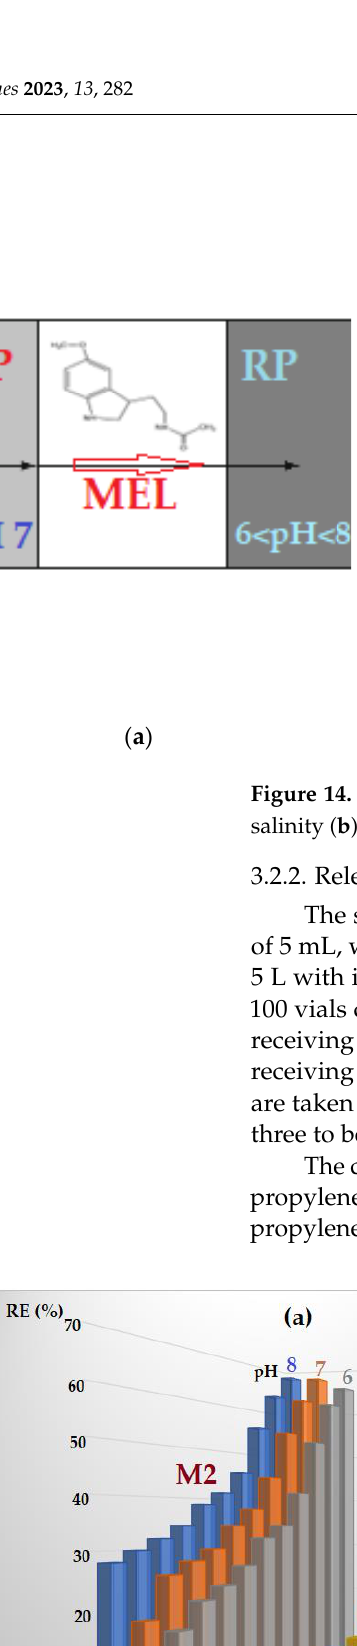
release over time.